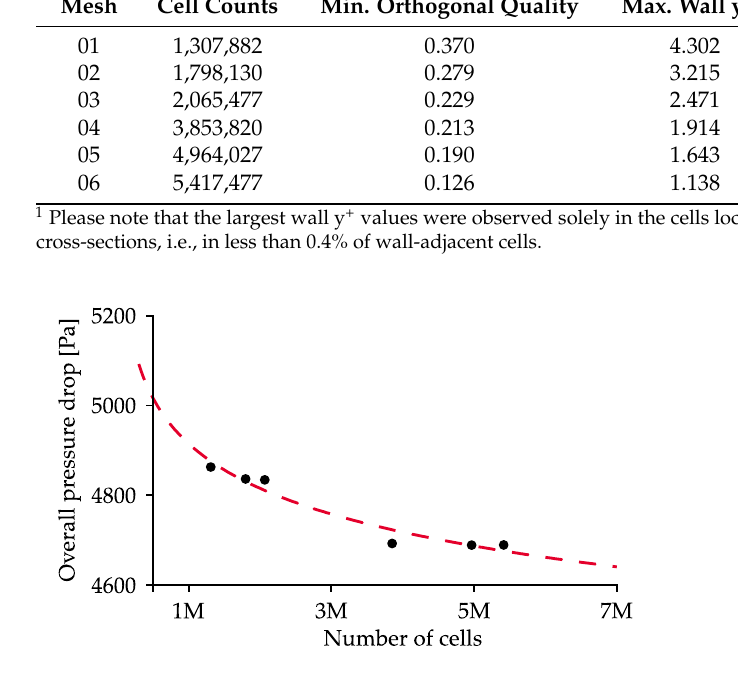
Figure 7. The effect of grid size on the overall pressure drop.